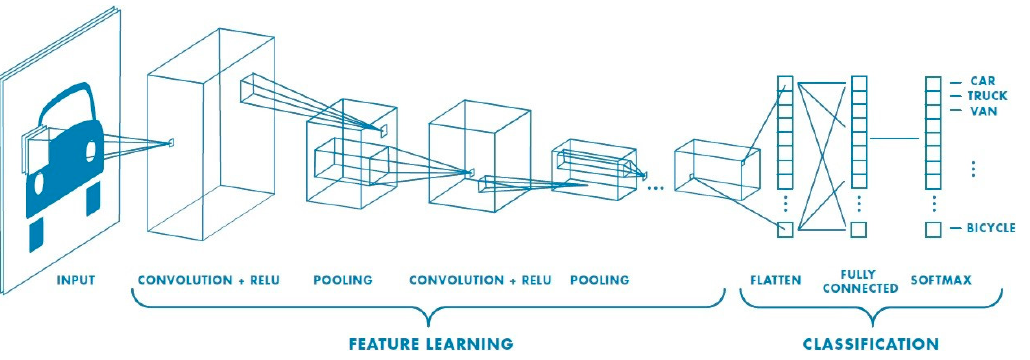
Figure 18. The general CNN configuration.